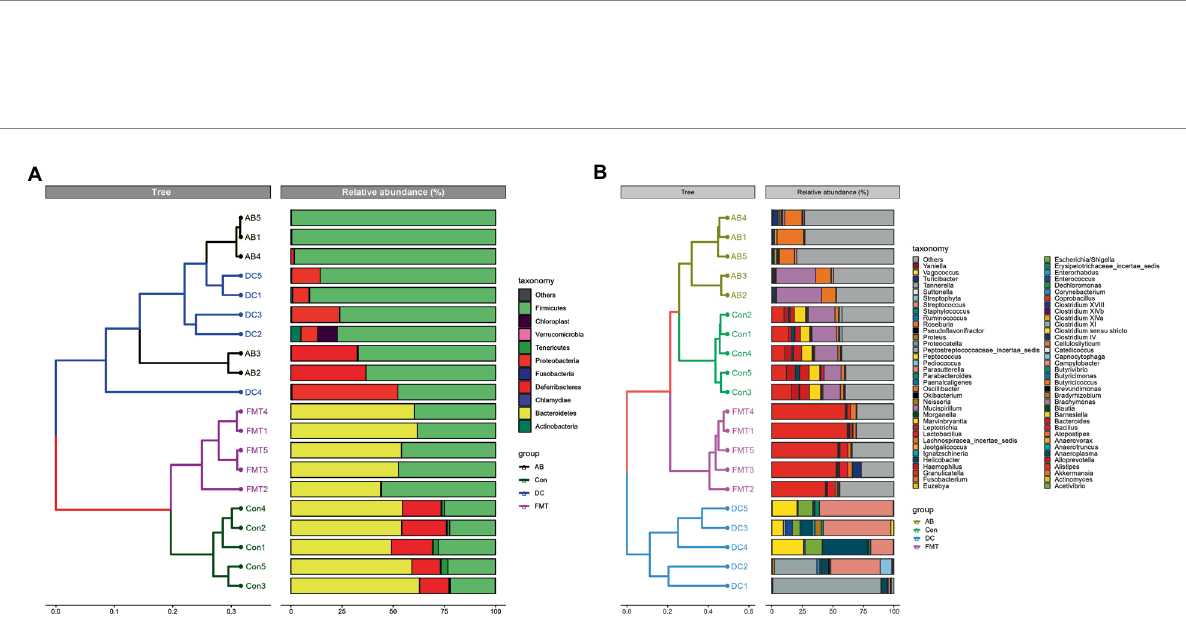
FIGURE 5 A Cluster analysis based on the Unifrac distance matrix (A) and on the weighted Unifrac distance (B) in groups at the phylum and genus levels. Control group: Con1, Con2, Con3, Con4, Con5. Antibiotic group: AB1, AB2, AB3, AB4, AB5. Decal microbiota transplantation group: FMT1, FMT2, FMT3, FMT4, FMT5. DC group: DC1, DC2, DC3, DC4,